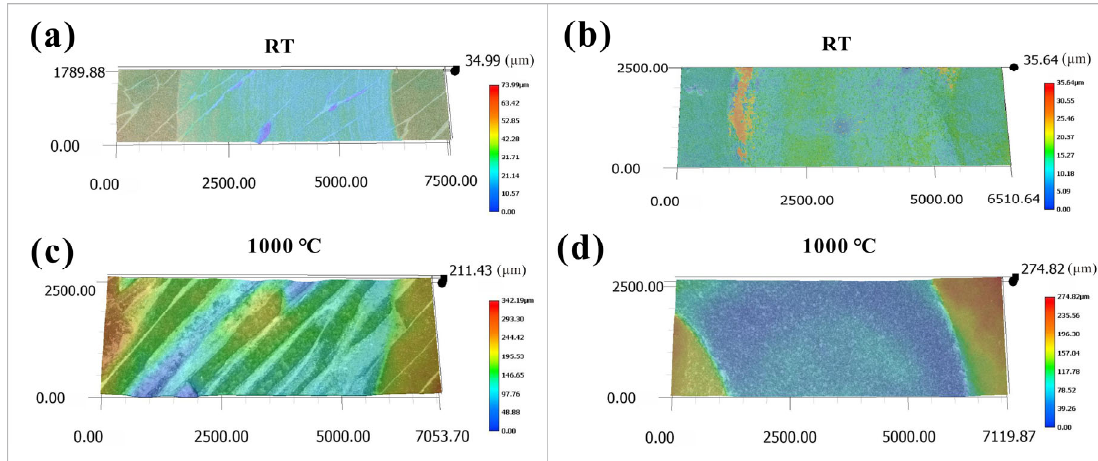
Fig. 10 3D topographies of the worn surfaces of (a, c) PcBN/hBN fibrous monolithic ceramics and (b, d) homogenous PcBN composites at different test temperatures.